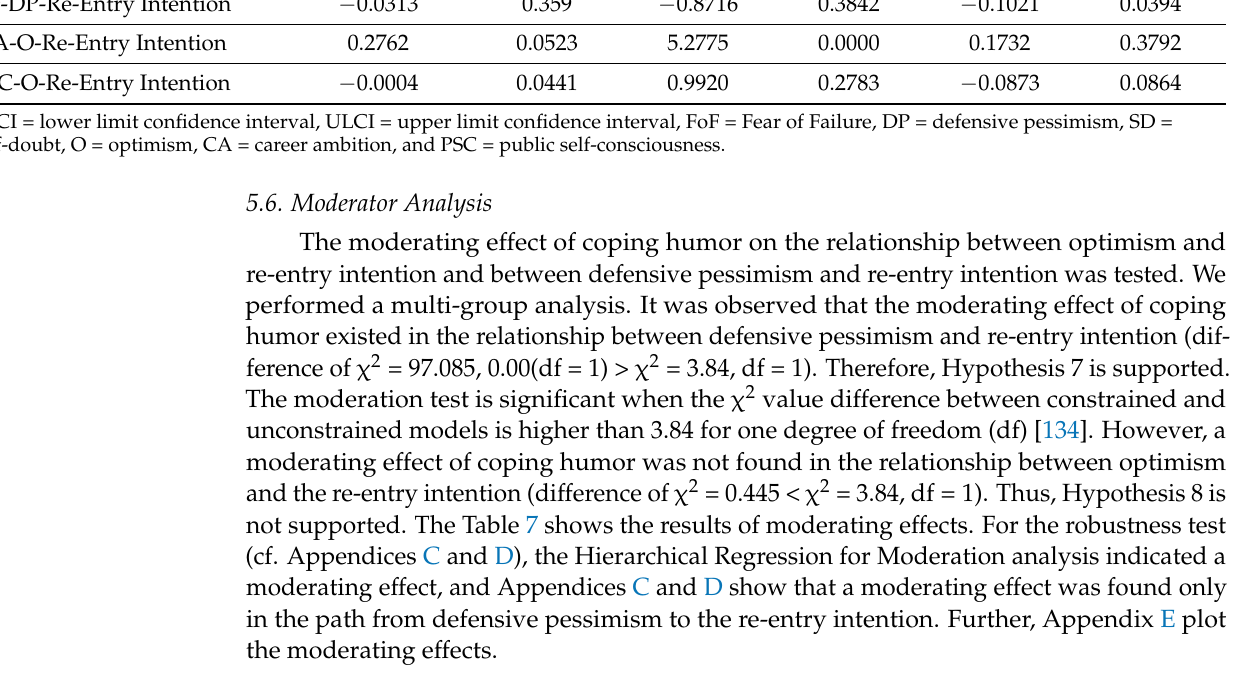
Table 7. Moderating effect